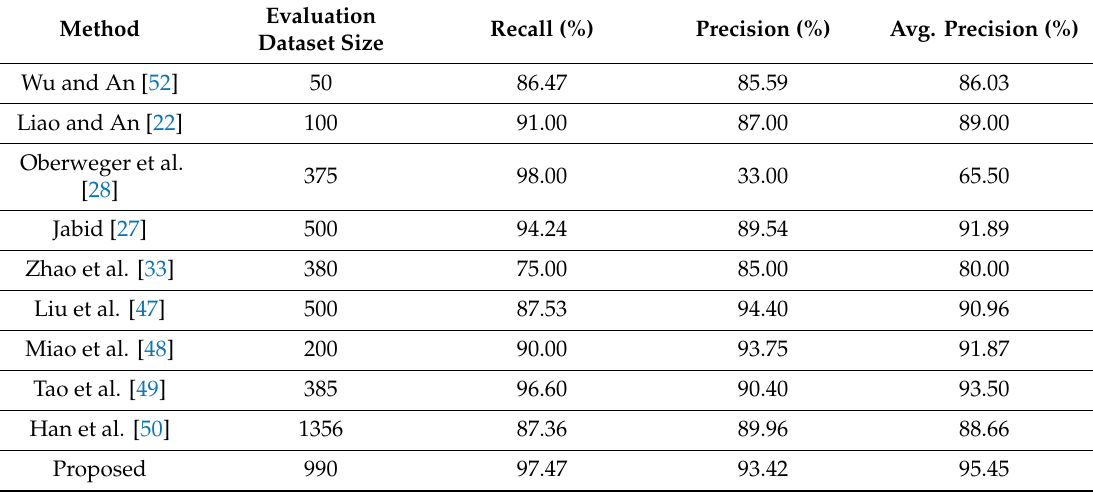
Table 2. Comparison of proposed CNN-based detector with the state-of-the-art insulator detectors.